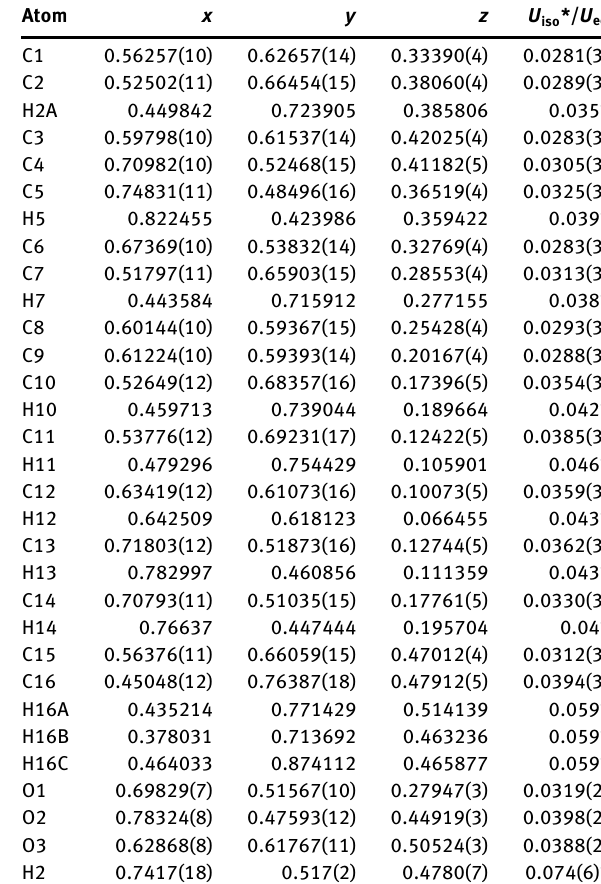
Table 2: Fractional atomic coordinates and isotropic or equivalent isotropic displacement parameters (Å 2